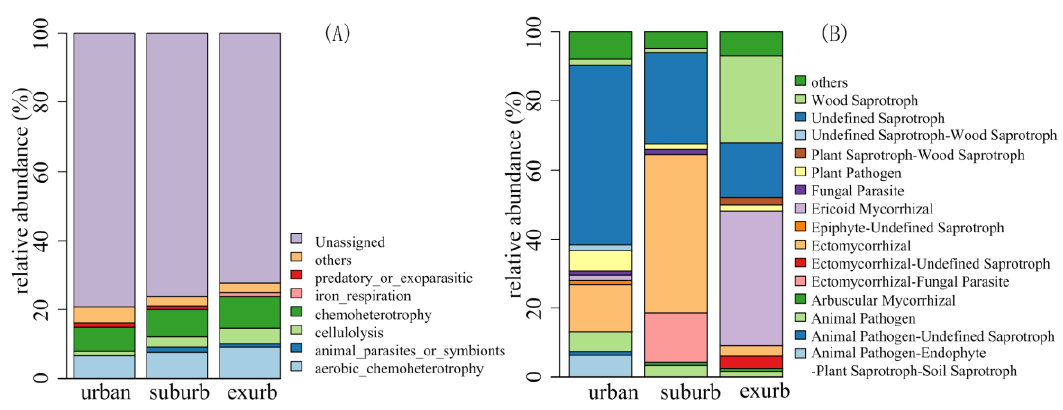
Figure 4. Relative abundance of bacterial ( A ) and fungal ( B ) functional groups along the urban-to-rural